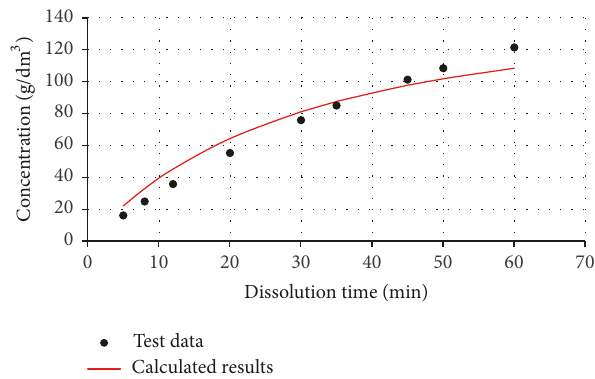
Figure 4: Comparison of the calculated results and test data of the transient dissolution of rock salt at 𝑄 = 2 cm 3 min −1 .